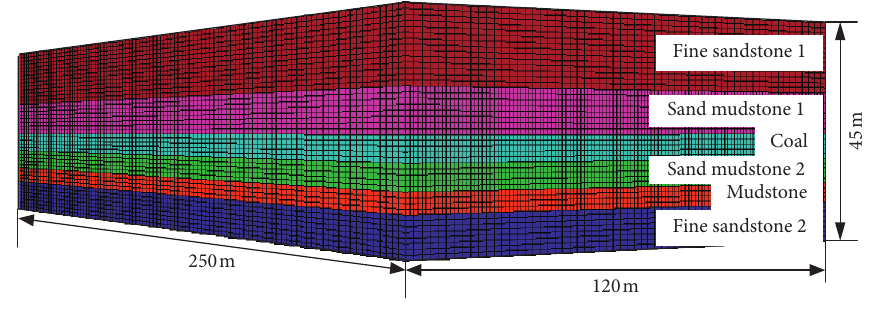
Figure 9: Numerical model. Table 4: Mechanical parameters of rock